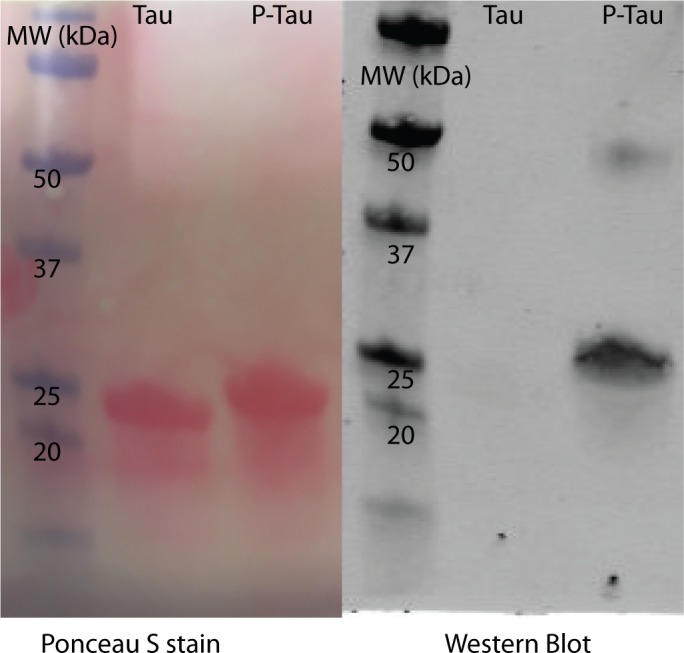
Tau in vitro phosphorylation.Tau (tau187C291S) were prepared as described in Materials and methods. Tau was subjected to in vitro phosphorylation using mouse brain extract as previously described (Despres et al., 2017). Phosphorylation was confirmed using SDS-PAGE and western blot analysis. Ponceau S staining of the blot shows equal loading of samples before (Tau) and after (P-Tau) the phosphorylation reaction, while reactivity with PHF-1 antibody indicates phosphorylation at S396/404.